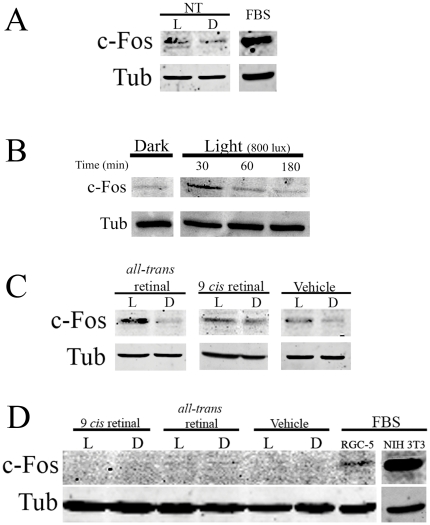
Induction of c-Fos protein in RGC-5 cells by light-stimulation.
A. c-Fos induction in RGC-5 cells without retinoids treatment (NT) after a 30 min pulse of cool white light or controls kept in the dark (image representative of 2 independent experiments) B. c-Fos induction in Vitamin A-supplied RGC-5 cultures after 30, 60 and 180 min of light exposure (800–1000 lux) or controls kept in the dark by WB. α-Tubulin (Tub) was used as a housekeeping protein. C. Immunostaining for c-Fos protein in RGC-5 cells exposed to light or kept in dark in the presence of all-trans retinal, 9 cis retinal, vehicle (representative of at least 3 independent experiments) and positive control of c-Fos induction by FBS stimulation. D. Immunostaining for c-Fos protein in NIH 3T3 cells (negative controls) exposed to light or kept in dark in the presence of all-trans retinal, 9 cis retinal or vehicle or no treatment (NT), and a positive control of c-Fos induction by FBS stimulation in RGC-5 and NIH 3T3 cells (representative of 2 independent experiments).